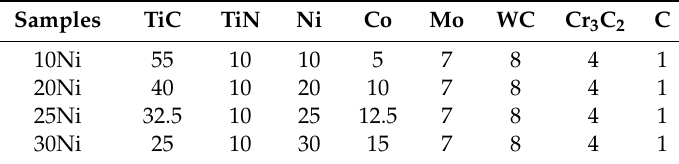
Table 3. Composition design of Ti(C,N)-based cermets (wt.%).